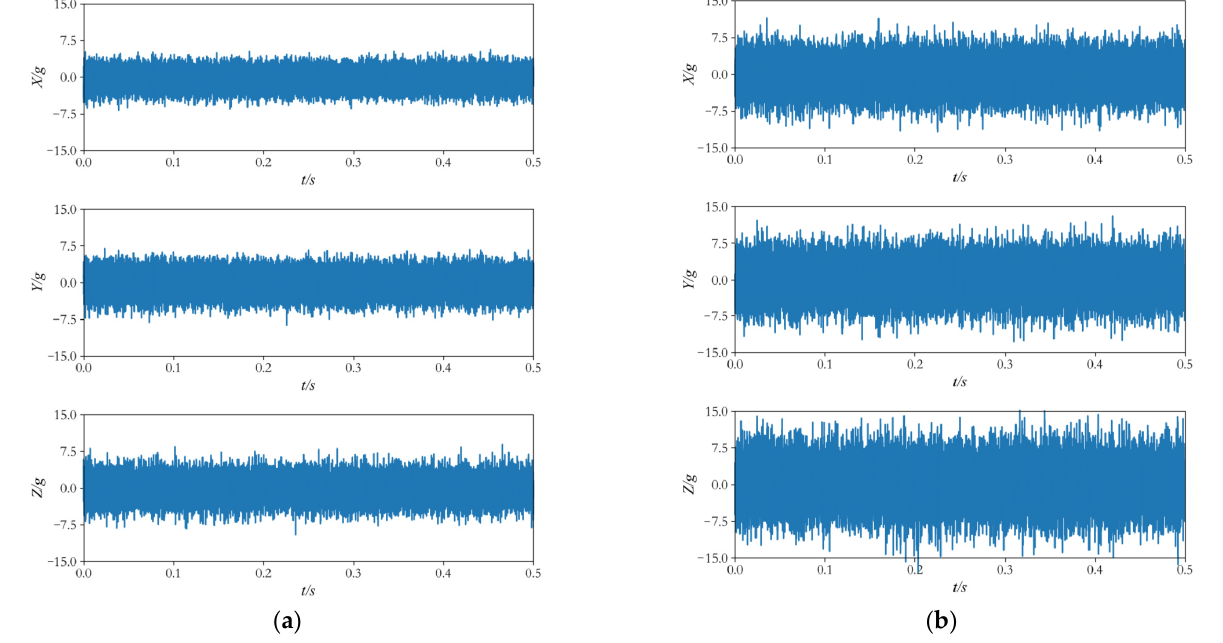
Figure 7. An illustration of the vibration signal. * The X-Axial vibration, Y-Radial vibration, and Z- Tangential vibration. ( a ) The three-directional vibration in the normal state; ( b ) the three-directional vibration in bearing circlip fault.